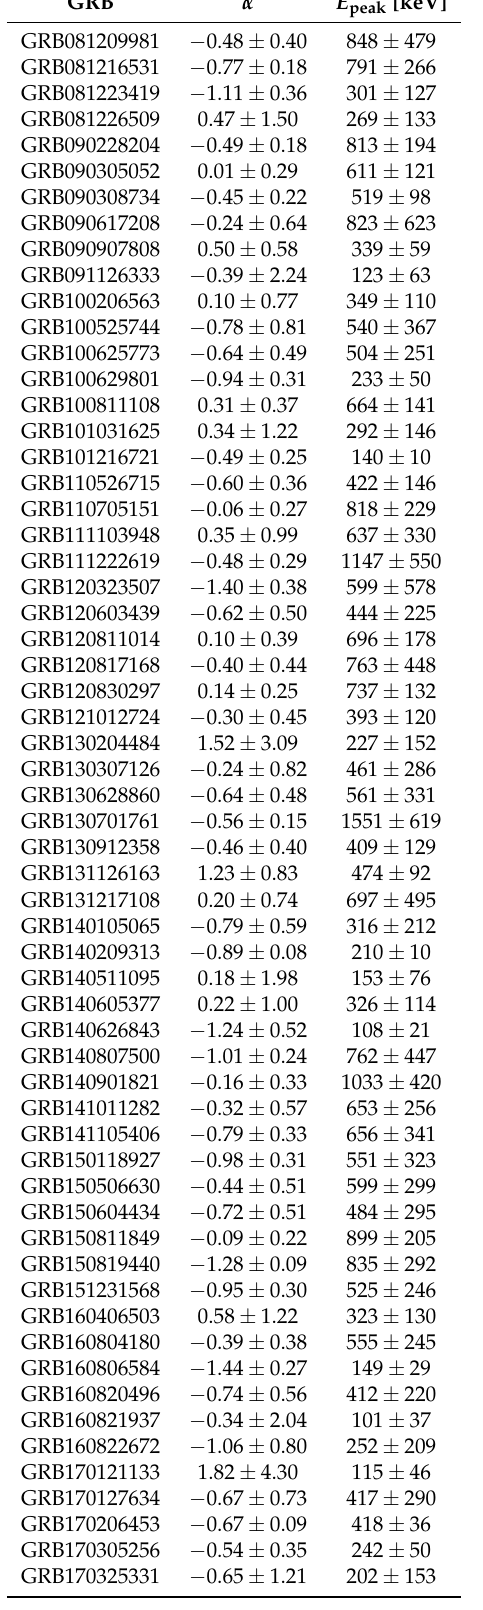
Table 1. Spectral parameters of short